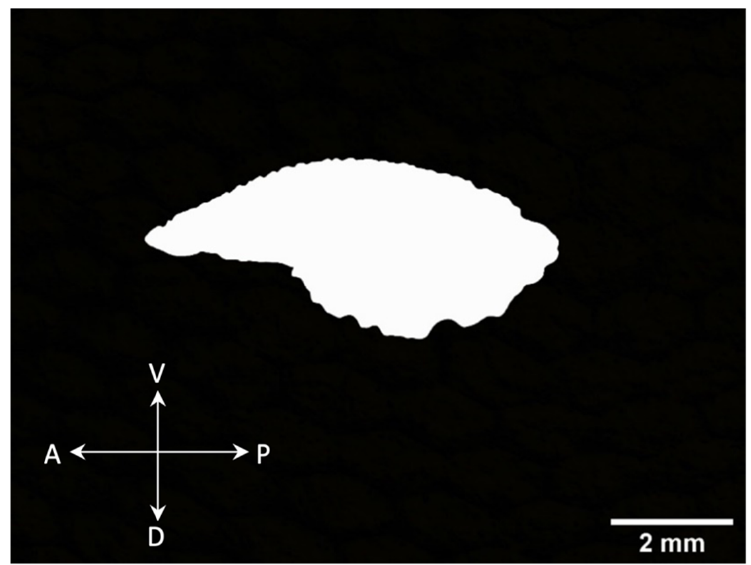
Figure 2. An edited image of Decapterus kurroides right otolith that was used for processing in R Studio using the ShapeR package. The directional map (cross) represents the position of the otolith: A (anterior); P (posterior); V (ventral); D (dorsal).